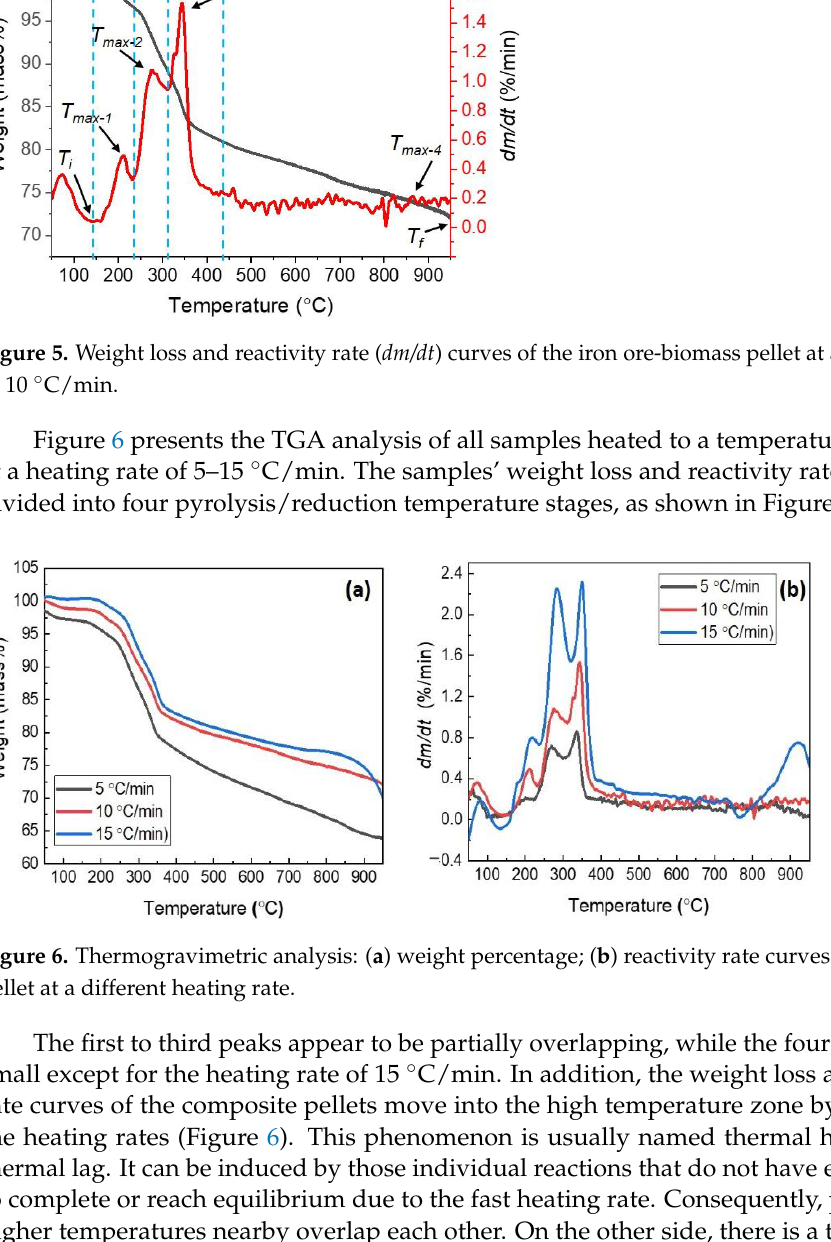
Figure 6. Thermogravimetric analysis: ( a ) weight percentage; ( b ) reactivity rate curves of composite pellet at a different heating rate.